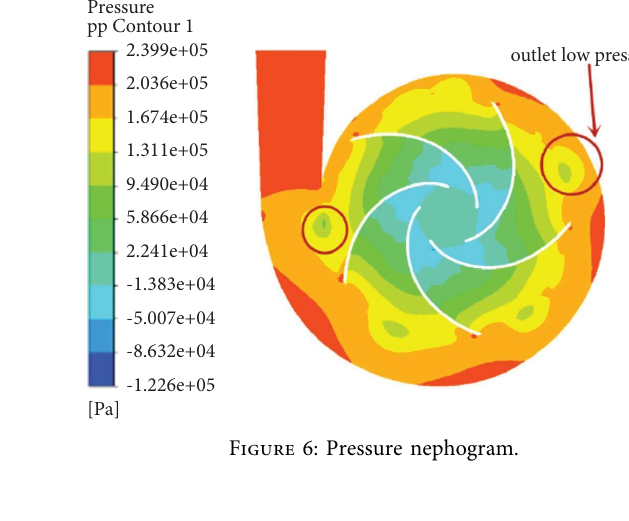
Figure 6: Pressure nephogram.